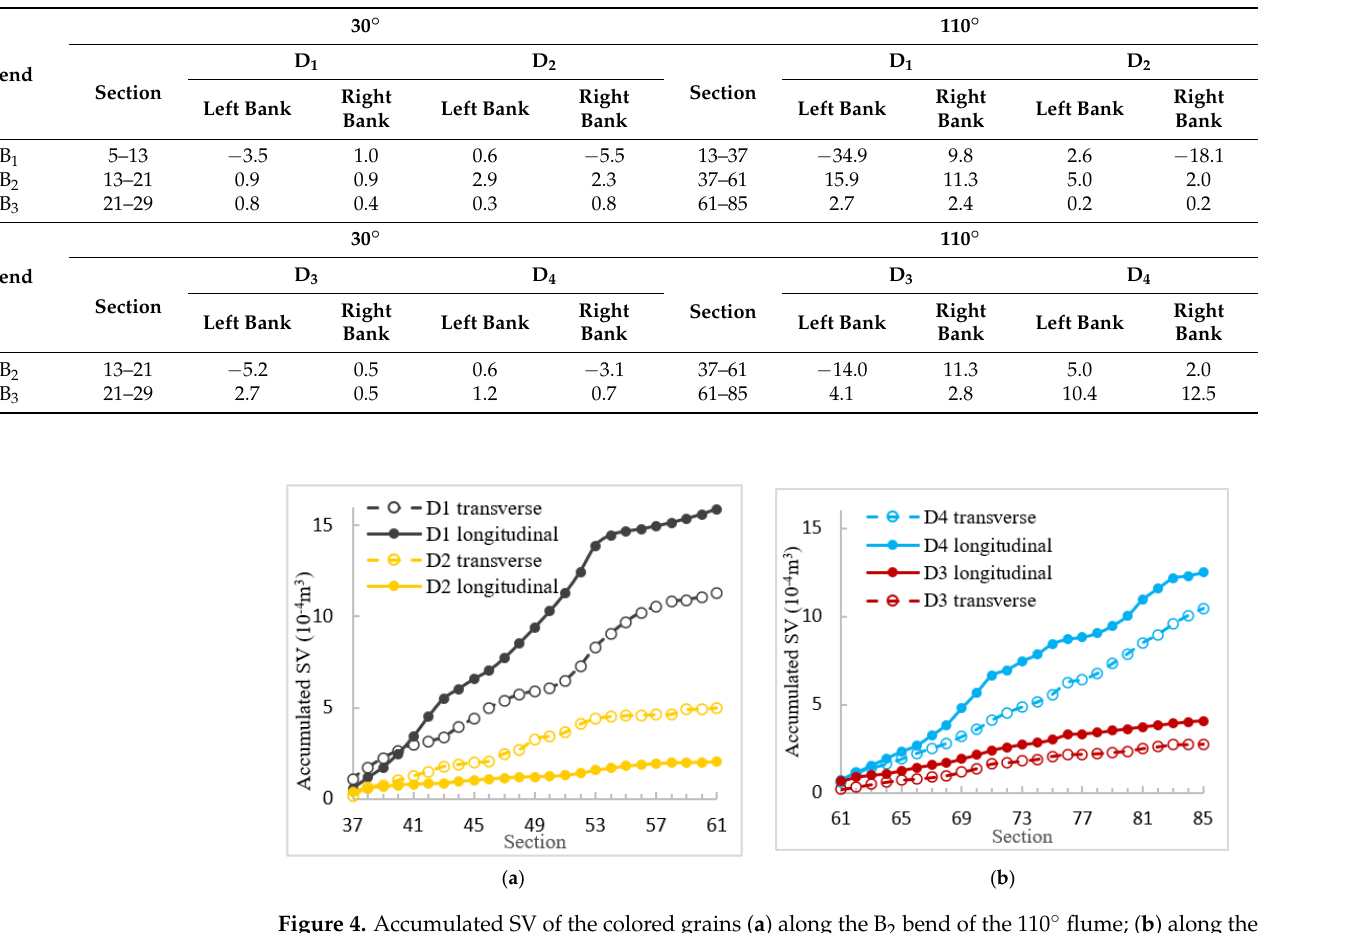
Table 3. Gain and loss of colored grains in the B 1 –B 3 bends (unit: 10 − 4 m 3 , negative values means loss and positive means gain).